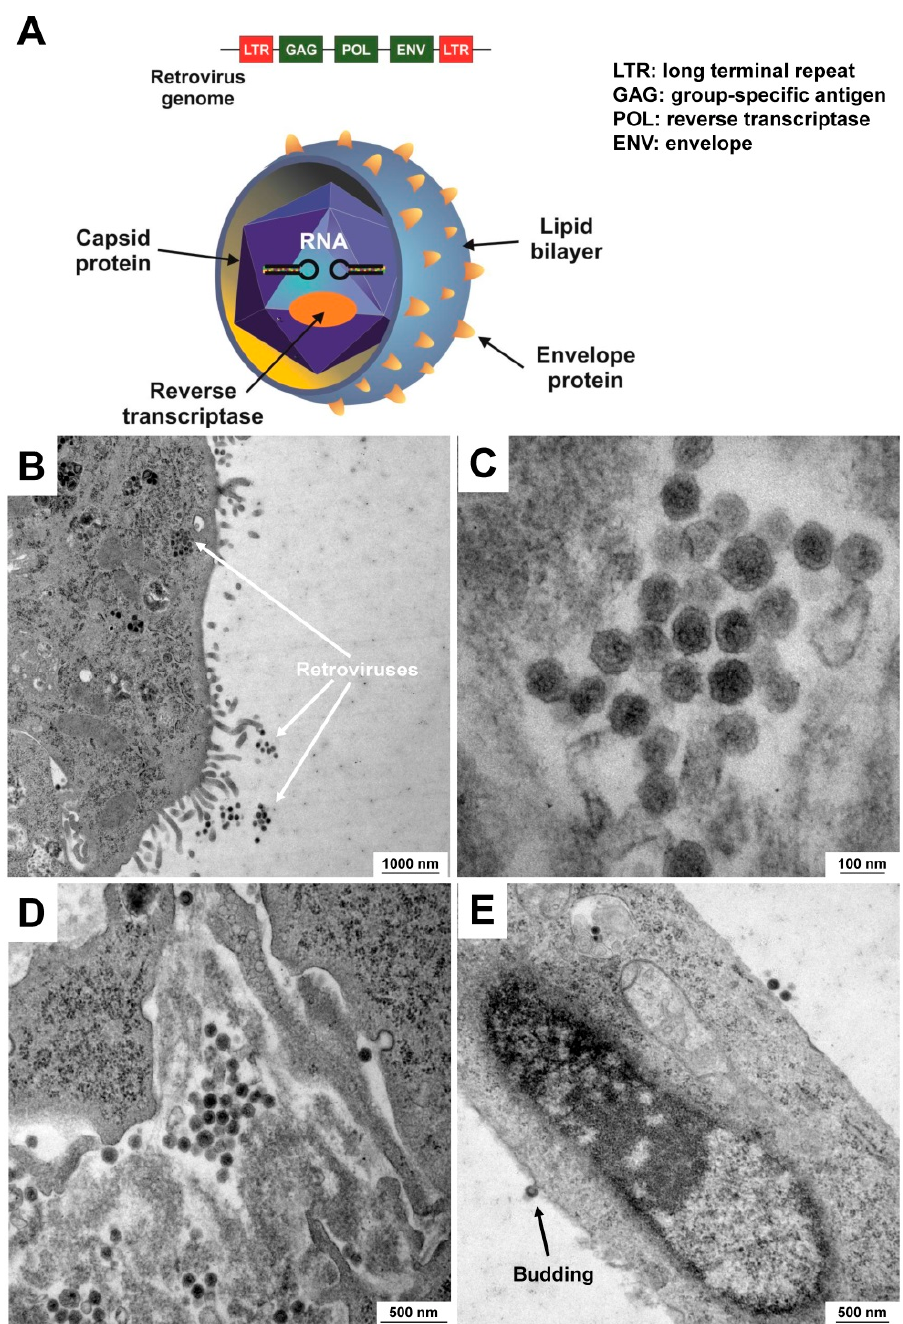
Figure 5. Retroviral contamination in the mouse cell line GRX. ( A ) General structure of a retrovirus. A retrovirus is an enveloped particle about 100 nm in diameter. The envelope encoded by the env gene is composed of glycoprotein that is encapsulated by lipids obtained from the plasma membrane of the host cells during the budding process. The retroviral genome further consists of two identical single-stranded RNA molecules 7–9 kb in length. Group-specific antigens (gag) are major components of the viral capsid, while the reverse transcriptase (pol) is necessary for synthesis of viral DNA. ( B ) Occurrence of a not-specified retrovirus in the mouse hepatic stellate line GRX as assessed by electron microscopic analysis. Retroviral particles can be found in the culture medium and in the cytosol. ( C , D ) Higher magnification images of retroviruses show the typical spherical structure. ( E ) This electron microscopic image shows a budding process in which a retroviral particle acquires its envelope by spreading through the host’s plasma membrane. Magnifications are 10,000 × ( B ), 100,000 × ( C ), 27,800 × ( D ), and 21,560 × ( E ),